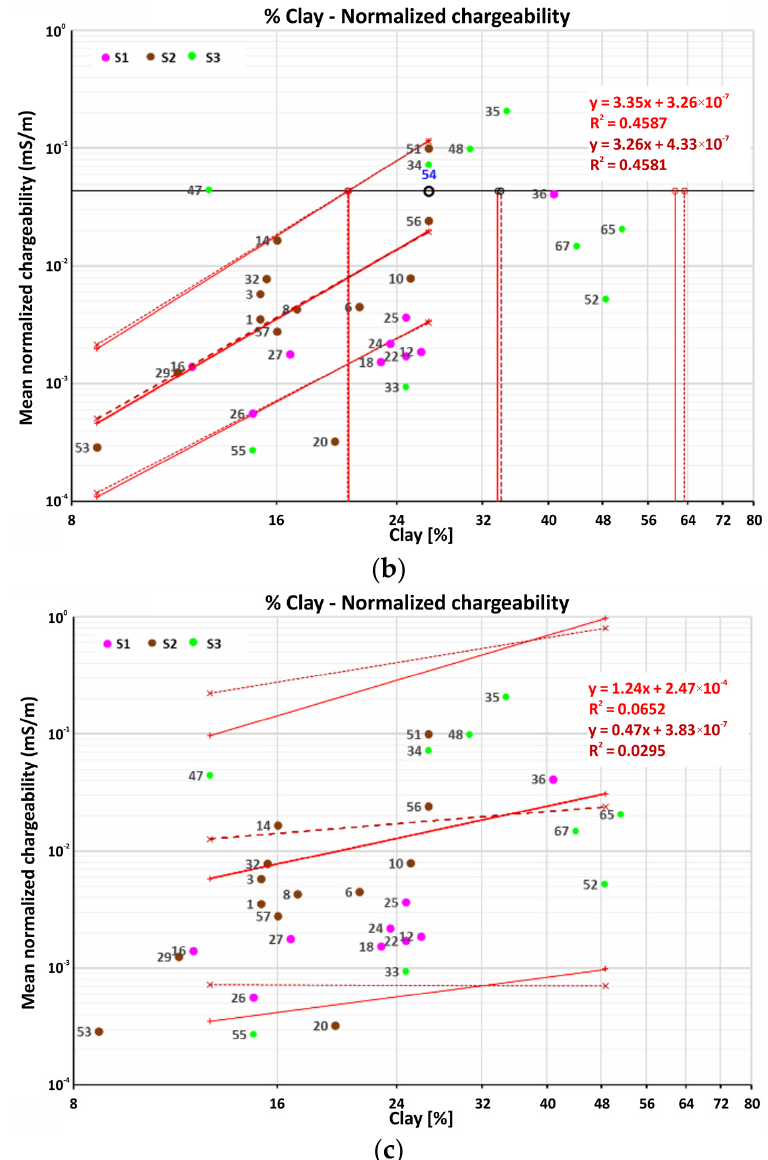
Figure 7. Clay (%) versus M n (mS/m) log–log diagrams with the data from the 33 sites surveyed during the dry period. Red solid and dark red dashed slanted lines correspond to the OLS and WLS linear regression, respectively. ( a ) The evaluation of the clay content (vertical solid and dashed lines) from the M n value for site #19 (black circle) from the S1 dataset; ( b ) the evaluation of the clay content (vertical solid and dashed lines) from the M n value for site #54 (black circle) from the S2 dataset. ( c ) The corresponding linear regression for the S3 subset. No clay content evaluation was performed due to poor data